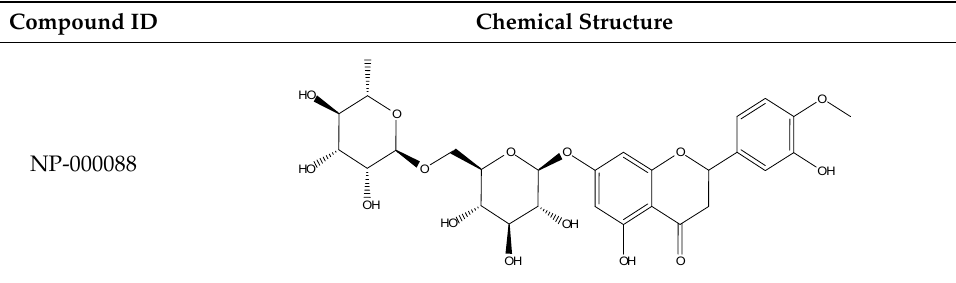
Table 3. Chemical structure of the nine selected compounds.